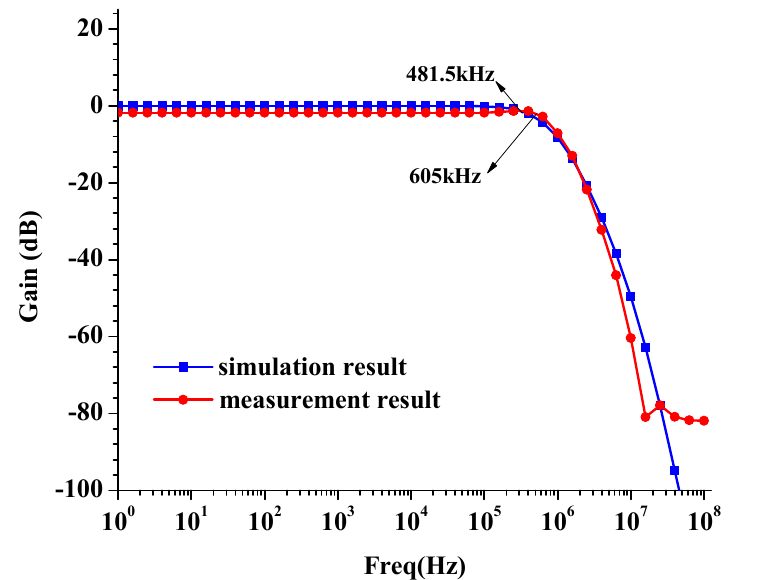
Figure 9. Comparison between the measurement and simulation results.